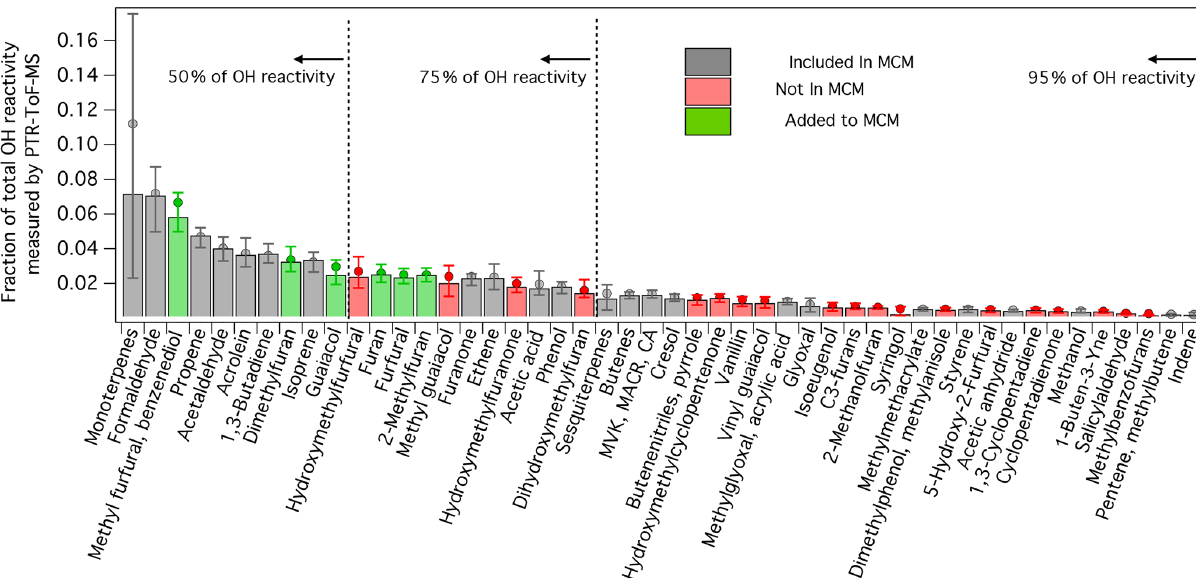
Figure 4. Contribution of individual species to the total primary OH reactivity estimated from PTR-ToF-MS measurements following Eq. (2). Bar intensity is median for all burns measured by PTR-ToF-MS, whereas circle markers are averages. Error bars indicate 25th and 75th percentiles. Bar colors indicate if a species is included (grey) or not included (red) in the MCM v. 3.3.1. Green bars indicate OH oxidation mechanisms that were added to the MCM (sub-mechanisms for each species can be found in Figs. S4–S9). The concentrations of each species were calculated following the methods described by Koss et al. (2018). Only species that were positively identified are included in these calculations. The assumed OH rate constant for each species is given by Koss et al.